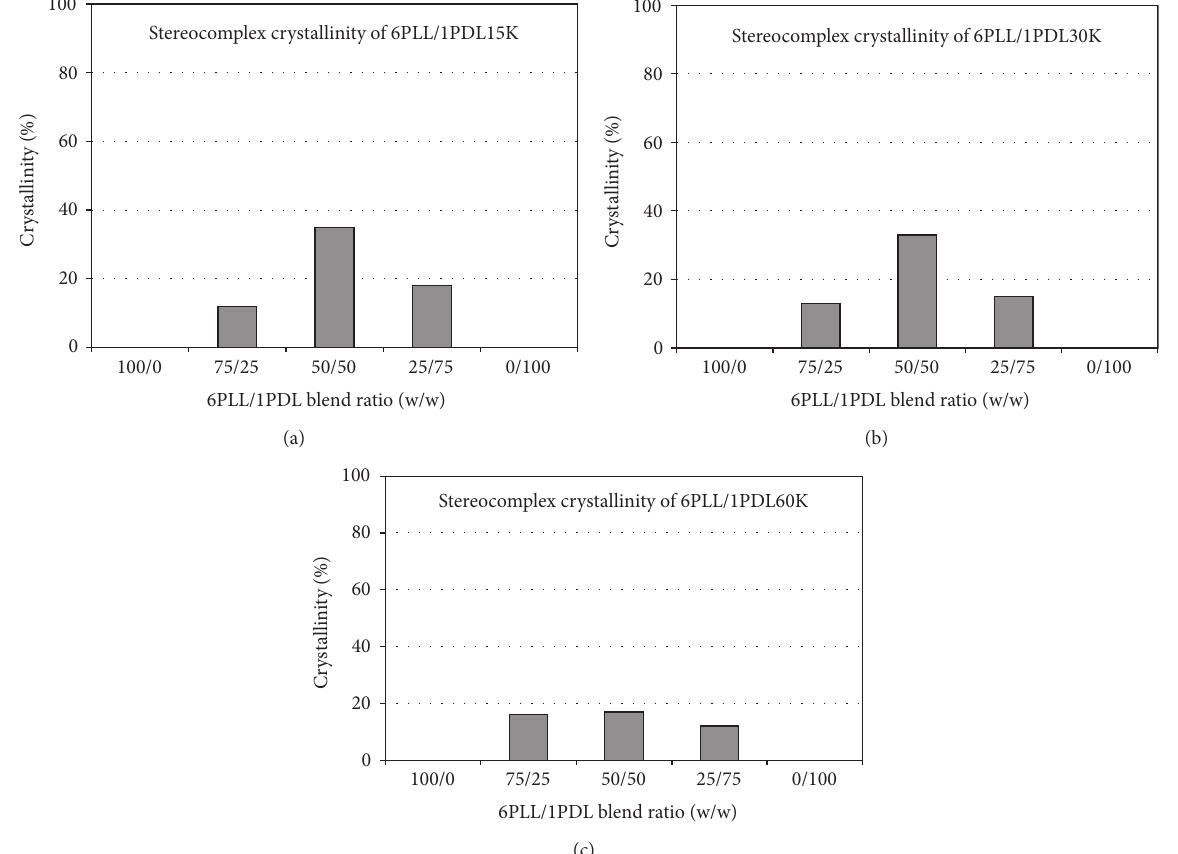
Figure 3: Stereocomplex crystallinity of 6PLL, 1PDL, and their polylactide stereocomplexes prepared with different 1PDL molecular weights and 6PLL/1PDL blend